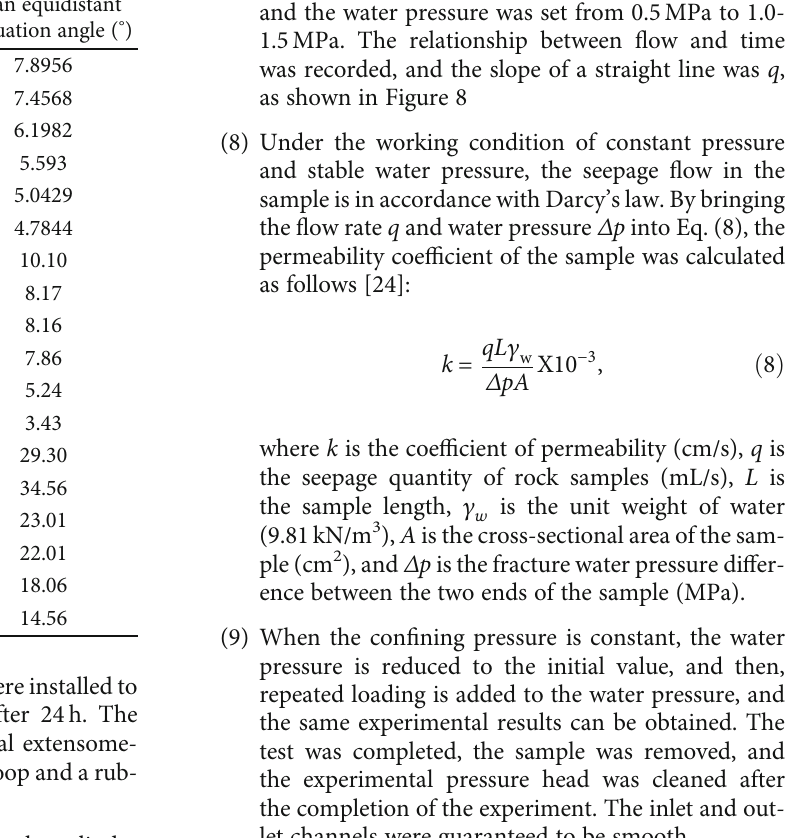
Table 1: Roughness index measurement results of the joint surface. Sample